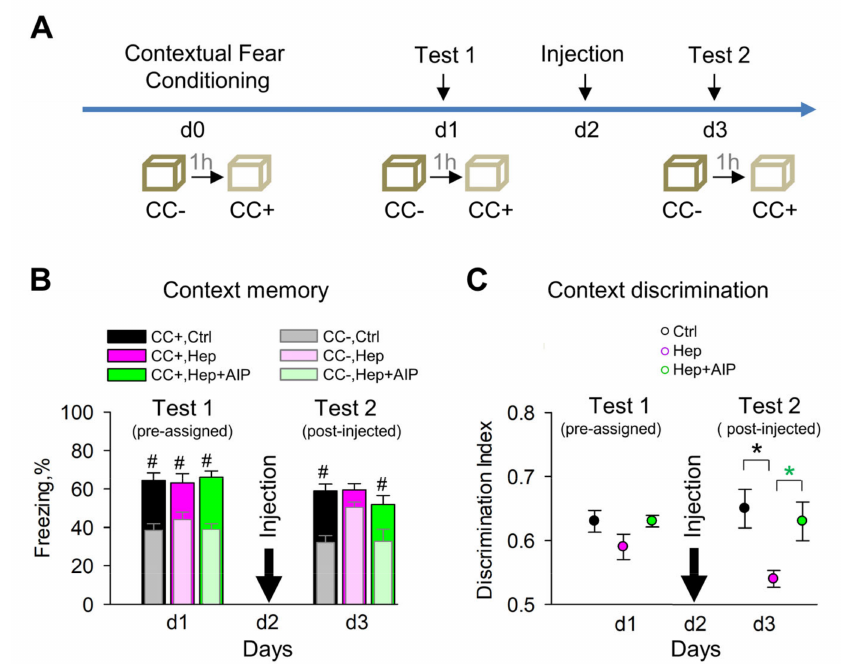
Figure 5. CaMKII inhibitor AIP rescues impaired context discrimination after heparinase (Hep) injection in vivo. ( A ) Scheme of the experiment. ( B , C ) Intrahippocampal heparinase injection 24 h after fear conditioning increases freezing in the neutral (CC-) context to the level measured in the conditioned (CC+) context ( B ) and impairs context discrimination ( C ), which can be rescued by inhibition of CaMKII with AIP. # p < 0.05, paired t-test to compare freezing in conditioned and